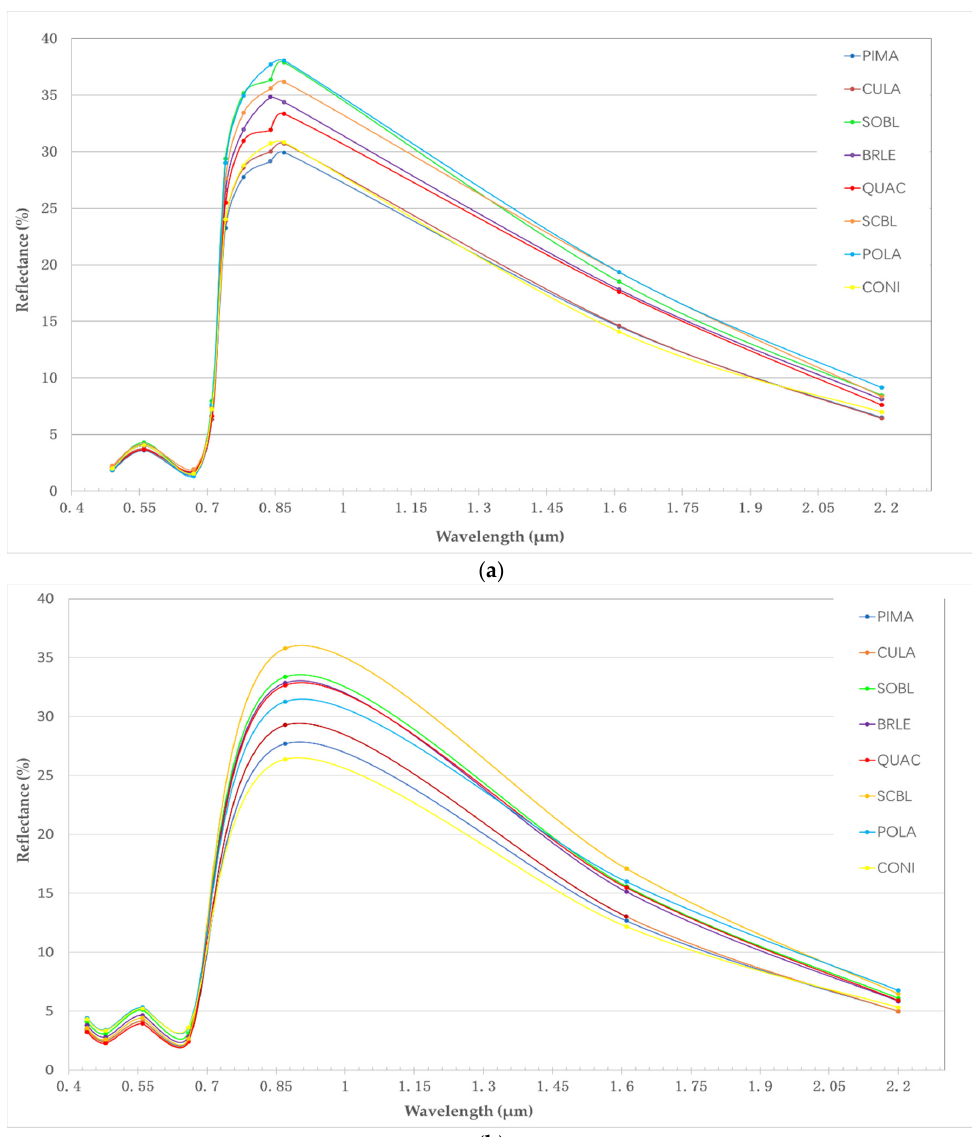
Figure 3. The mean spectral characteristic of tree species in Sentinel-2A ( a ) and Lansat-8 ( b ) imagery. The legend abbreviations are Chinese red pine ( Pinus Massoniana , PIMA), China fir ( Cunninghamia lanceolata , CULA), German oak ( Quercus acutissima , QUAC), Chinese white poplar ( Populus lasiocarpa , POLA), mixed Sclerophyllous Broad-Leaved forest (SCBL), mixed Soft Broad-Leaved forest (SOBL), mixed Broad-Leaved forest (BRLE) and mixed Coniferous forest